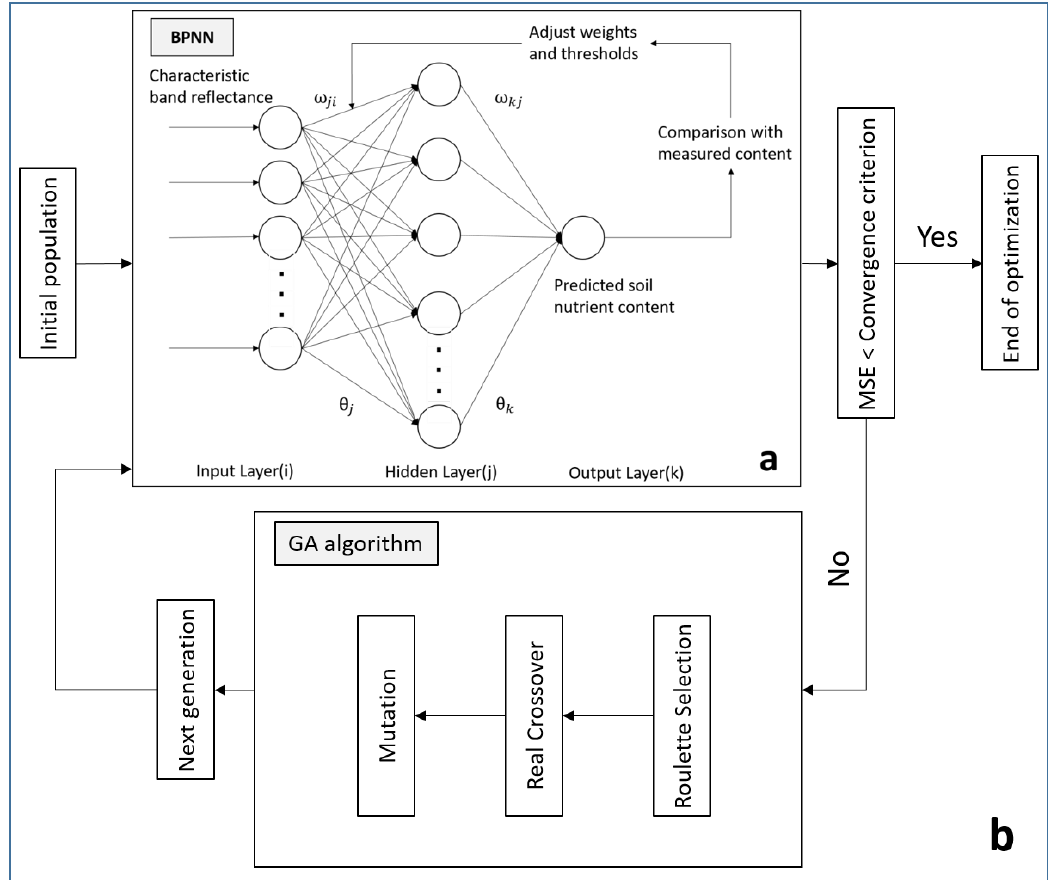
Figure 5. The structures of ( a ) back propagation neural network (BPNN) and ( b ) GA-BPNN.